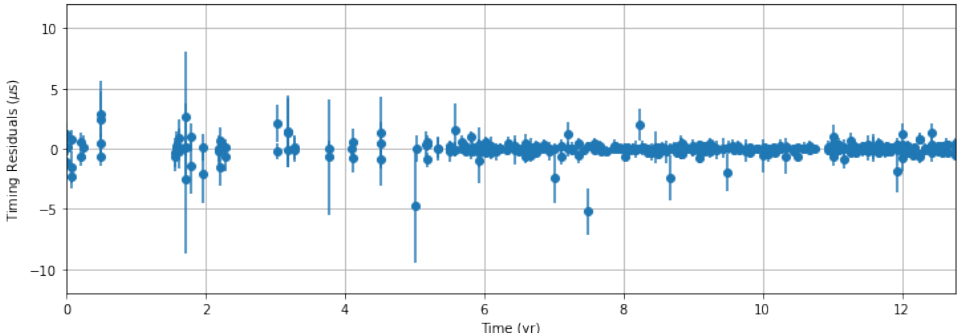
Figure 7. Plot of the wideband post-fit whitened TRs of the MSP J2145–0750, which are from the 12.5 yr Data Set published by the NANOGrav collaboration. The horizontal axis indicates the time, expressed in years. The vertical axis indicates the wideband post-fit whitened TRs, expressed in